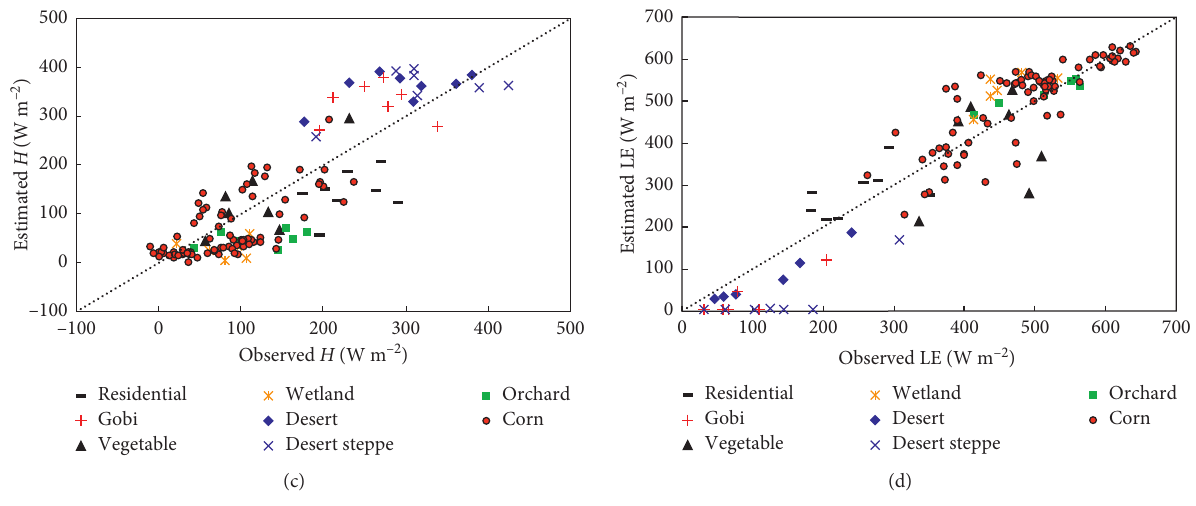
Figure 4: Estimated (a) R n , (b) G , (c) H , and (d) LE vs. ground observations.